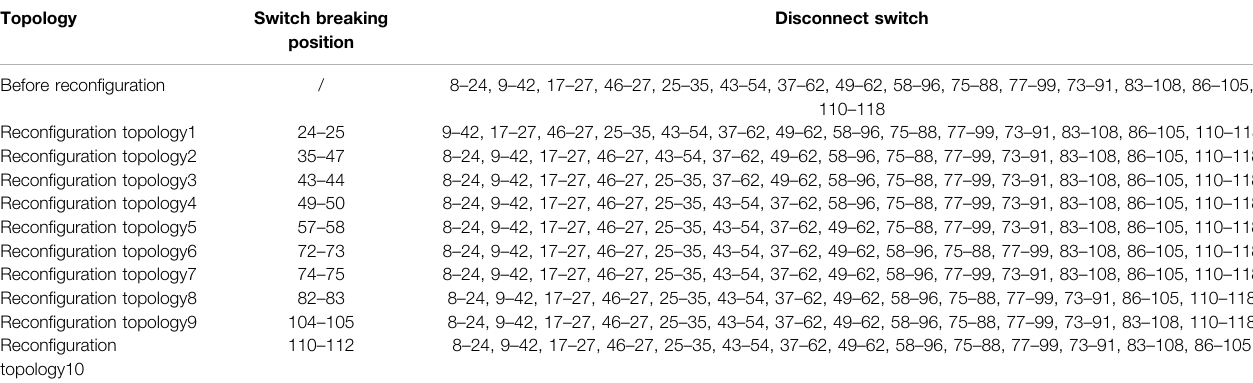
TABLE 1 | IEEE-118 system topology Recon fi guration.